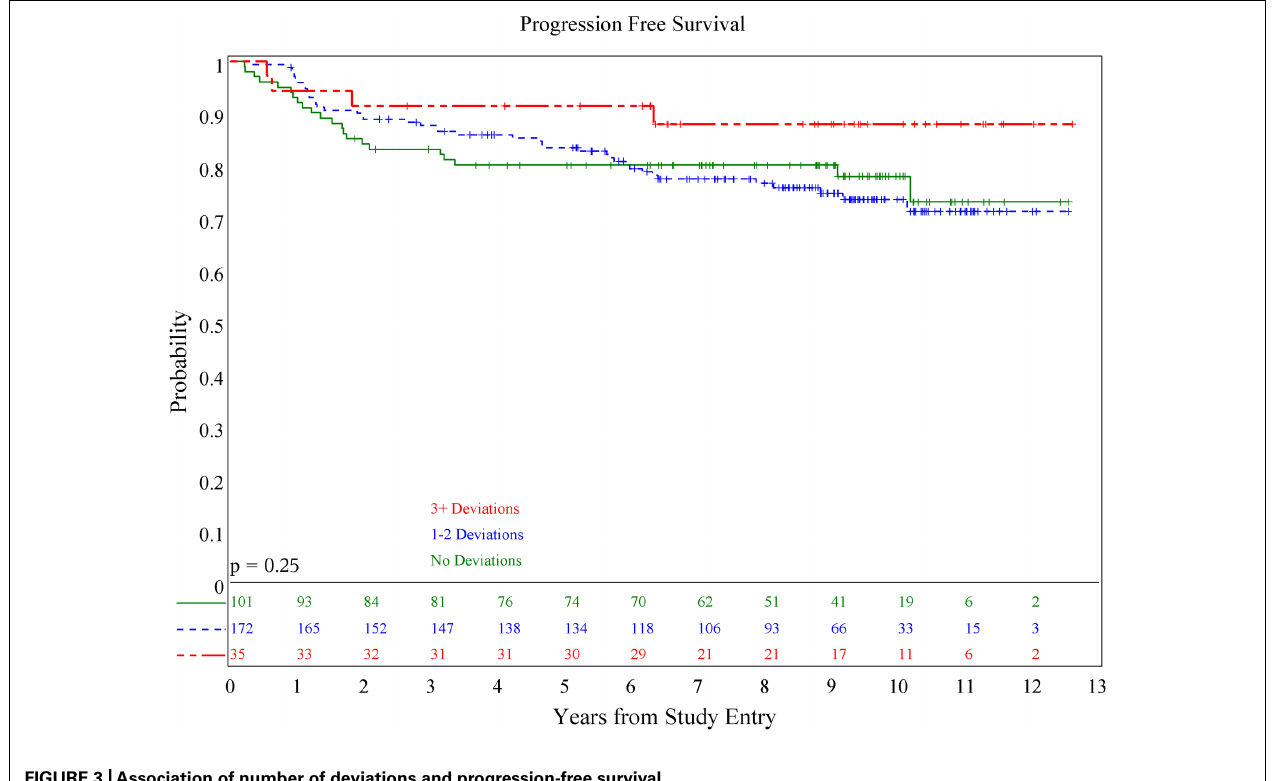
FIGURE 3 |Association of number of deviations and progression-free survival.